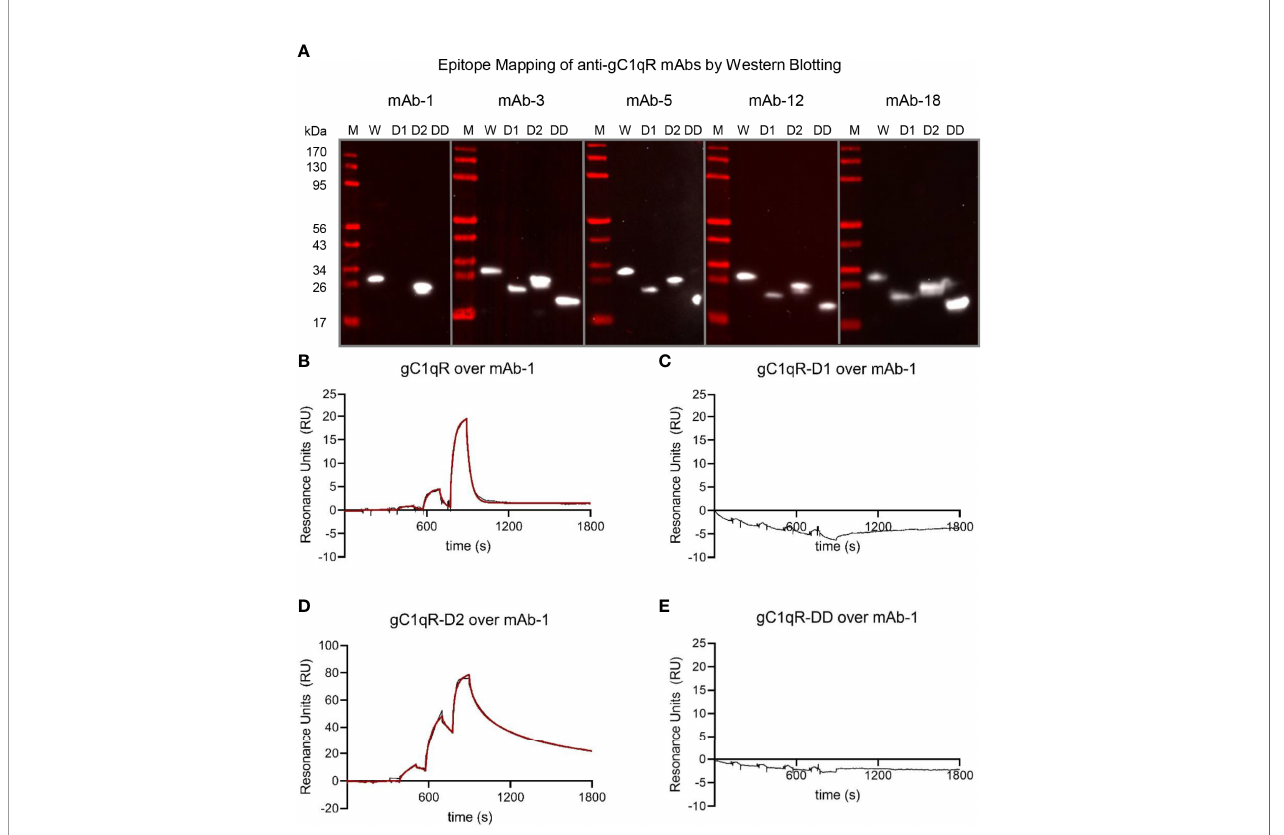
FIGURE 5 | The Epitope of mAb-1 Lies in the First Acidic Loop of gC1qR. The locations of the epitopes for novel anti-gC1qR monoclonal antibodies were mapped using a combination of Western blotting and surface plasmon resonance. (A) Epitope mapping by Western blotting. Samples of wild-type gC1qR, gC1qR-D1, gC1qR-D2, and gC1qR-DD were separated by SDS-PAGE, transferred to membranes, and probed with various monoclonal antibodies prior to detection using a chemiluminescent approach. Images representing individual experiments are separated by grey lines, while the values for molecular weight standards are shown at the left of the panel. Note that only mAb-1 showed differential reactivity to forms of gC1qR missing the acidic loops. (B) Reference-corrected sensorgram from a single-cycle kinetic study where a fi ve-fold dilution series of wild-type gC1qR (1 m M highest concentration) was injected over a surface of immobilized mAb-1. The black trace represents the experimental data, while the red line represents the outcome of fi tting to a kinetic model. (C) Identical to panel (B) , except that gC1qR-D1 served as the analyte. (D) Identical to panel (B) , except that gC1qR-D2 served as the analyte. (E) Identical to panel (B) , except that gC1qR-DD served as the analyte. Note that panels (C, E) do not show the outcome of a fi t, since there was no appreciable binding of mAb-1 to those